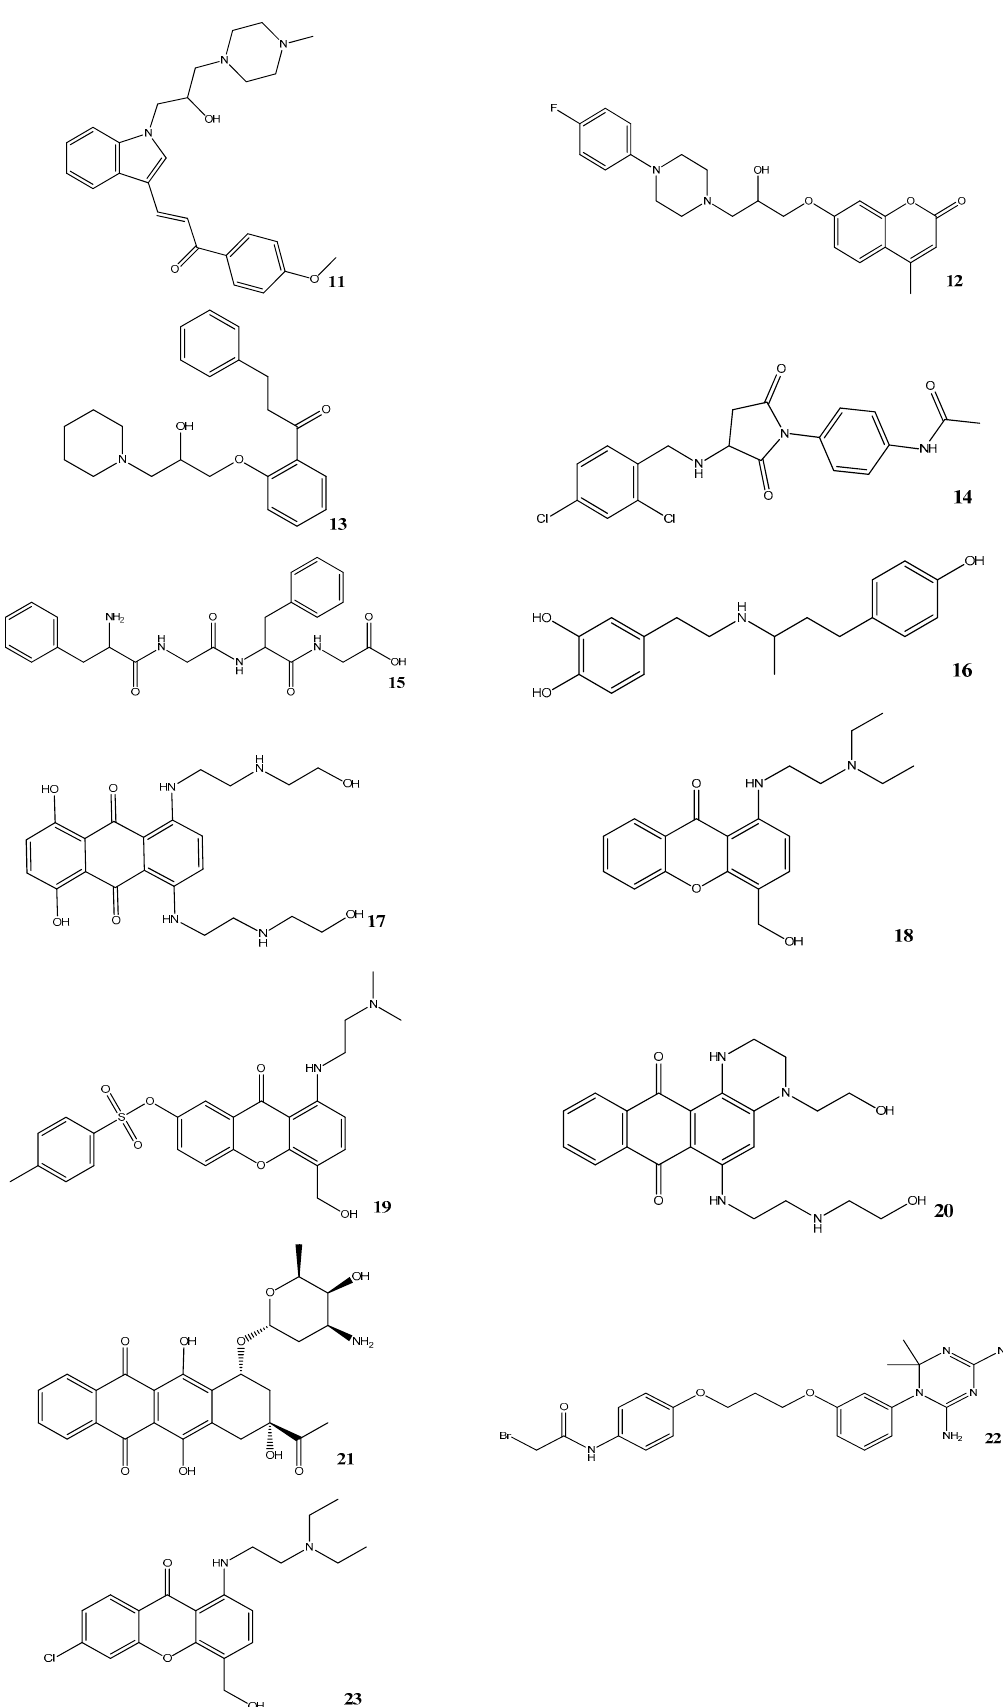
Figure 7. Chemical structures of the compounds identified herein as hit BACE1